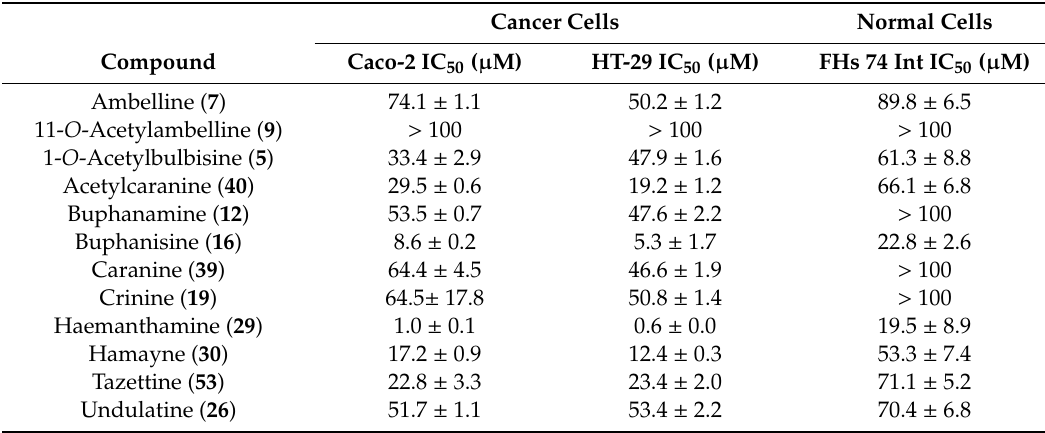
Table 3. Cytotoxicity of AA isolated from N. bowdenii against two cancer cell lines and one noncancerous gastrointestinal cell line